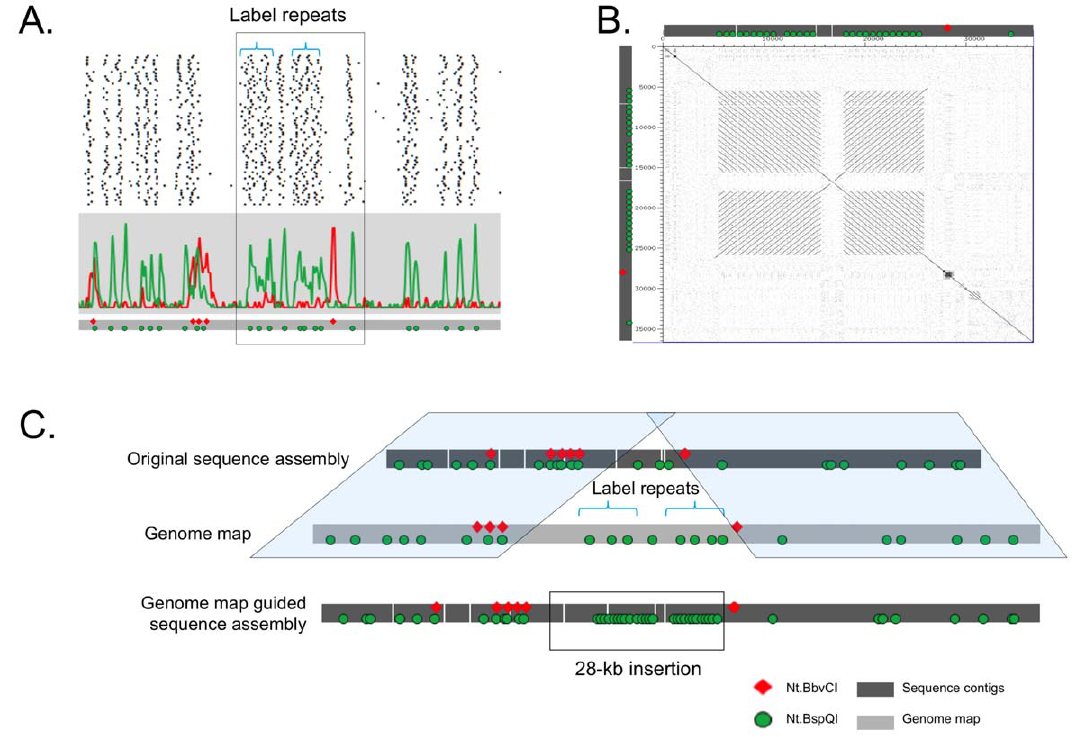
Figure 6. Identification and assembly of repeat sequences in genome map-guided denovo sequence assembly. Panel A shows the strip diagram for one of the clones that covers the high density region, each line represents a different molecule and the spots are the location of green (Nt.BspQI) labels. Two high-density label regions are marked ‘‘label repeats,’’ and they do not cluster into discrete peaks. Panel B shows a pairwise alignment of the high-density region after reassembly based on the genome map. The alignment shows two blocks of direct repeats which are inverted with respect to one another. Panel C shows the original assembly on the top, the genome map in the middle and the final assembly on the bottom, containing the repeat sequence as predicted by the genome